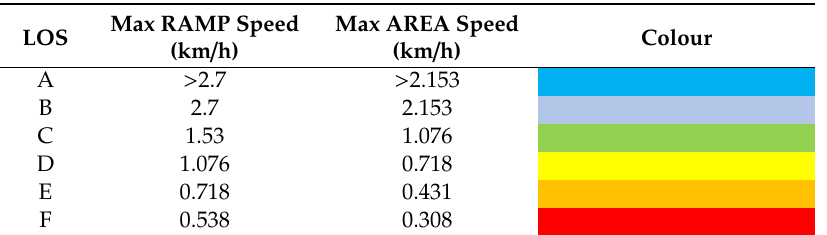
Table 8. LOS range related to RAMP and